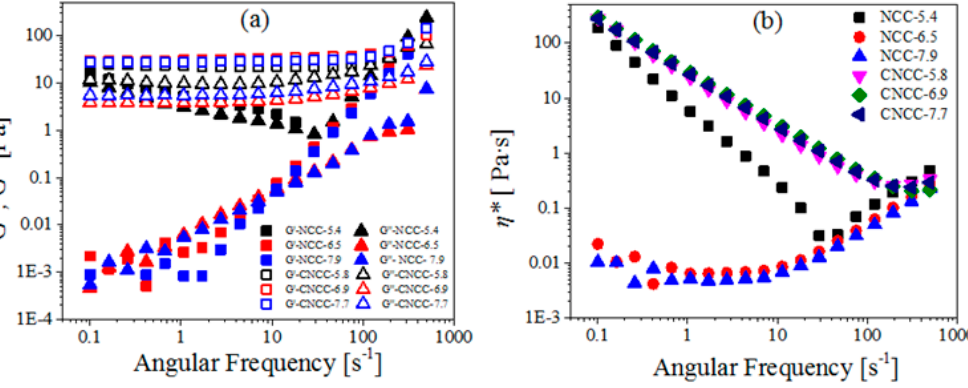
Figure 4. ( a ) Storage modulus ( G ′ ), loss modulus ( G ″ ), and ( b ) Complex viscosity ( η * ) as a function of angular frequency for NCC and CNCC suspensions at different pH. angular frequency for NCC and CNCC suspensions at different